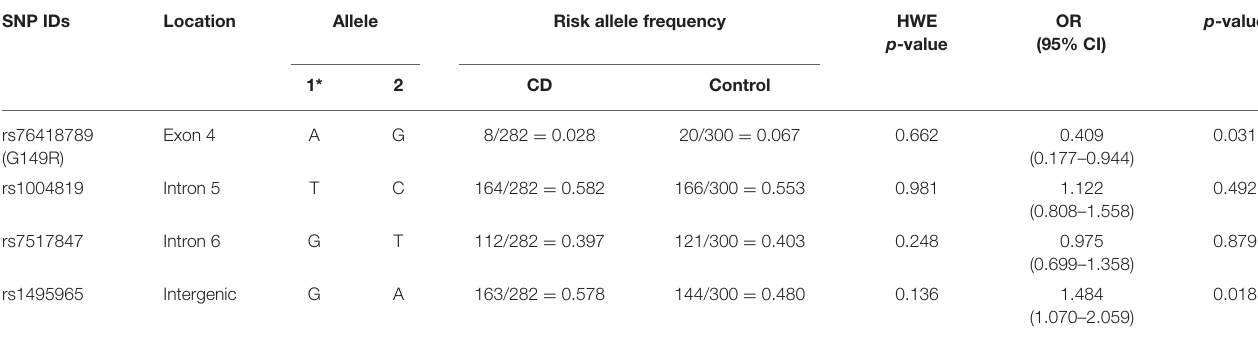
TABLE 3 | Allele frequency of patients with Crohn’s disease and controls.